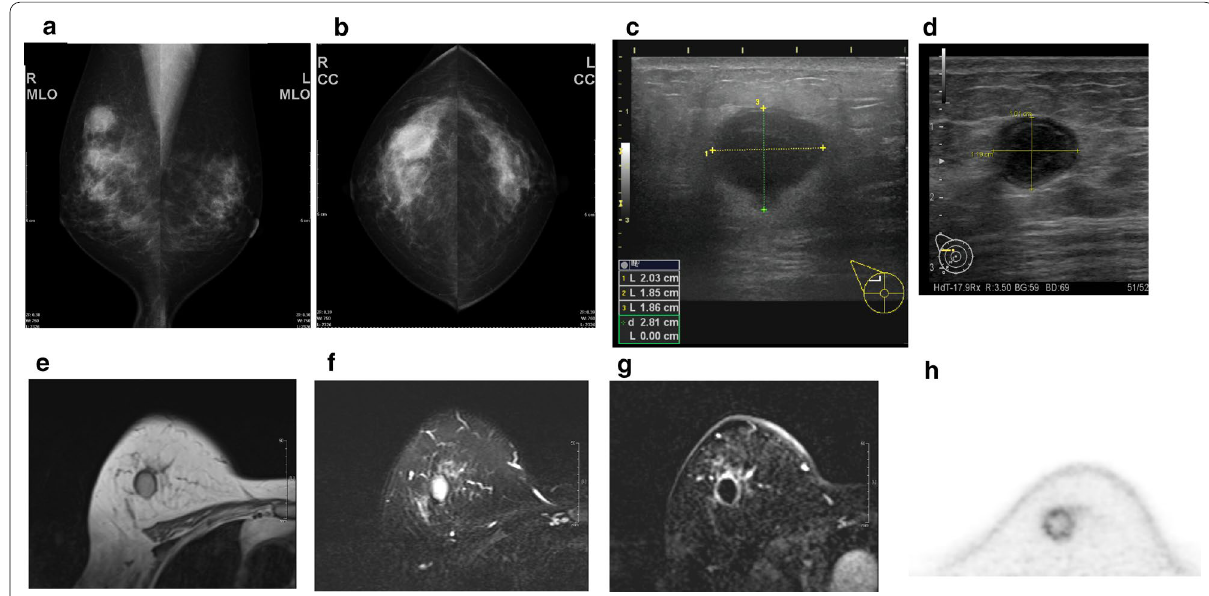
Fig. 1 Preoperative imaging findings. a Mediolateral oblique-view mammogram. b Craniocaudal-view mammogram. A mass with a clear boundary is recognized in the right breast. c Ultrasonogram at first visit. A smooth, round mass is apparent in the upper-outer quadrant of the right breast. Subcutaneous fat tissue around the tumor appears as a highly echogenic, edematous layer. d Ultrasonogram just before surgery. Edema around the tumor has disappeared. e T1-weighted magnetic resonance imaging (MRI). f T2-weighted MRI. g MRI with early gadolinium enhancement A smooth, round mass with slight hyperintensity on T1-weighted MRI and hyperintensity on T2-weighted MRI. Only the marginal region of the tumor appears enhanced. h Ring-type dedicated breast positron emission tomography. A ring-shaped accumulation of 18 F-fluorodeoxyglucose is evident in the right